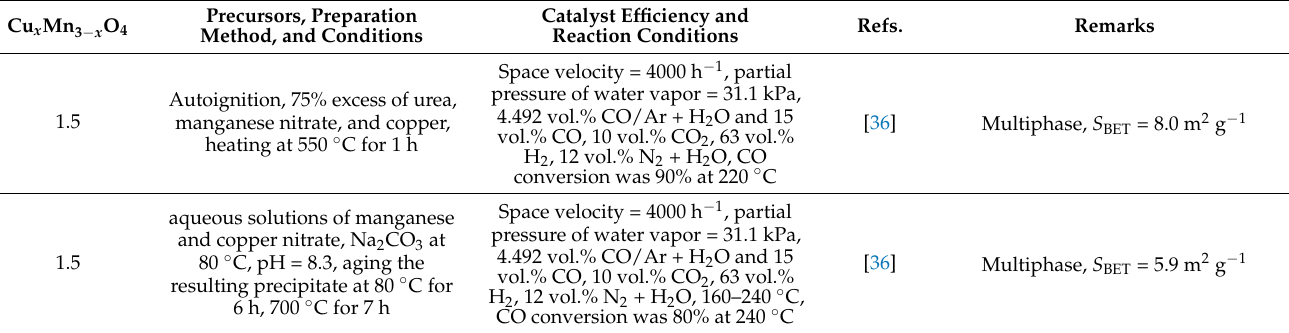
Table 10. The water–gas shift reaction in the presence of Cu x Mn 3 − x O 4 catalysts.